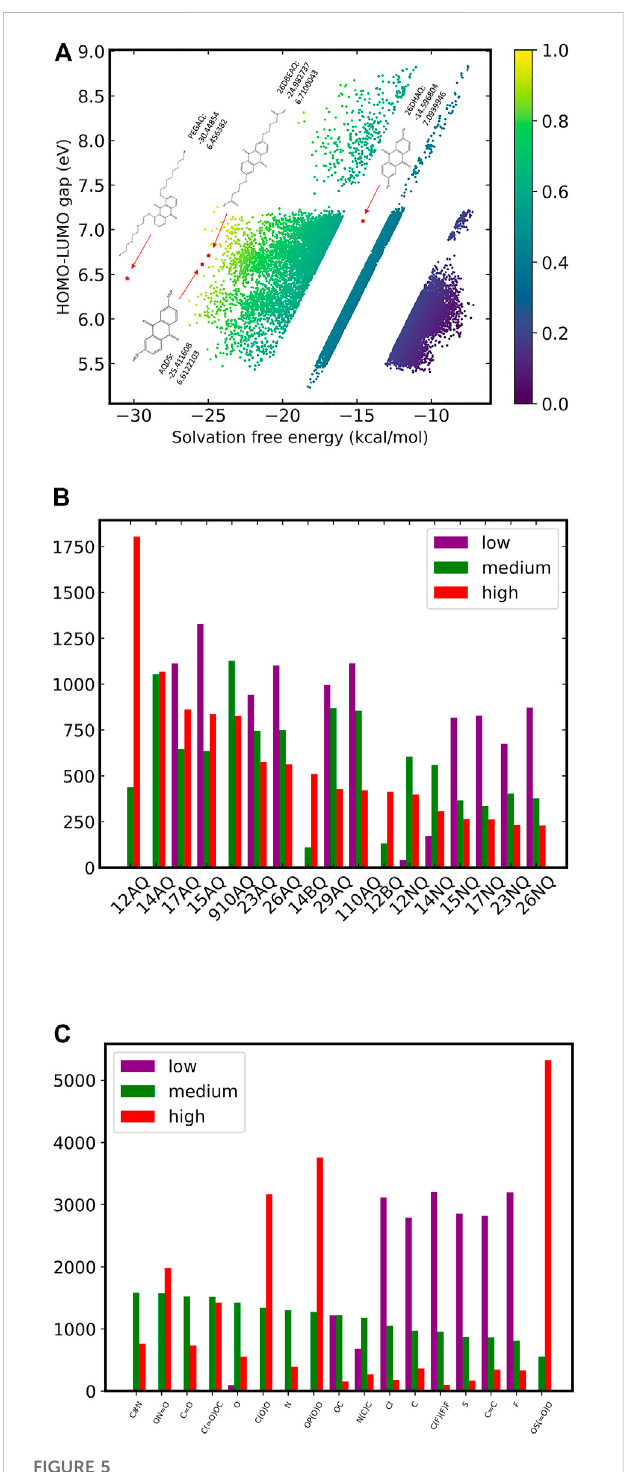
FIGURE 5 Virtual molecular library scoring and analysis of results. (A) Scoring chart for di-substituted quinones and reported quinone-based electrode materials; (B) Backbone distribution in three types of scoring molecules; (C) Distribution of substituent types in three types of scoring